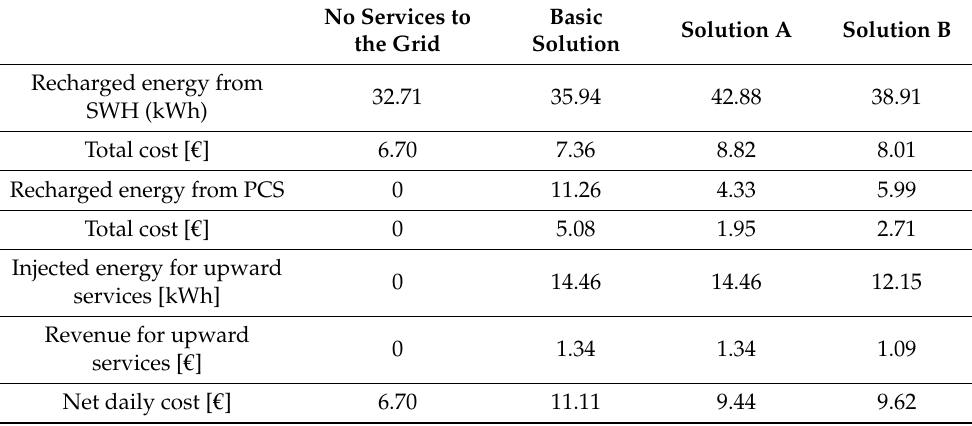
Table 15. Summary of costs and revenues for the analyzed solutions—mobility pattern